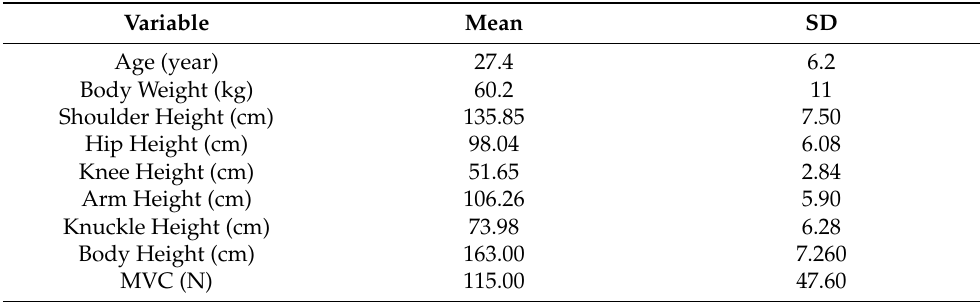
Table 1. Descriptive statistics of anthropometric measurements and maximum voluntary contraction (MVC) measured in newton(N). SD: standard deviation.